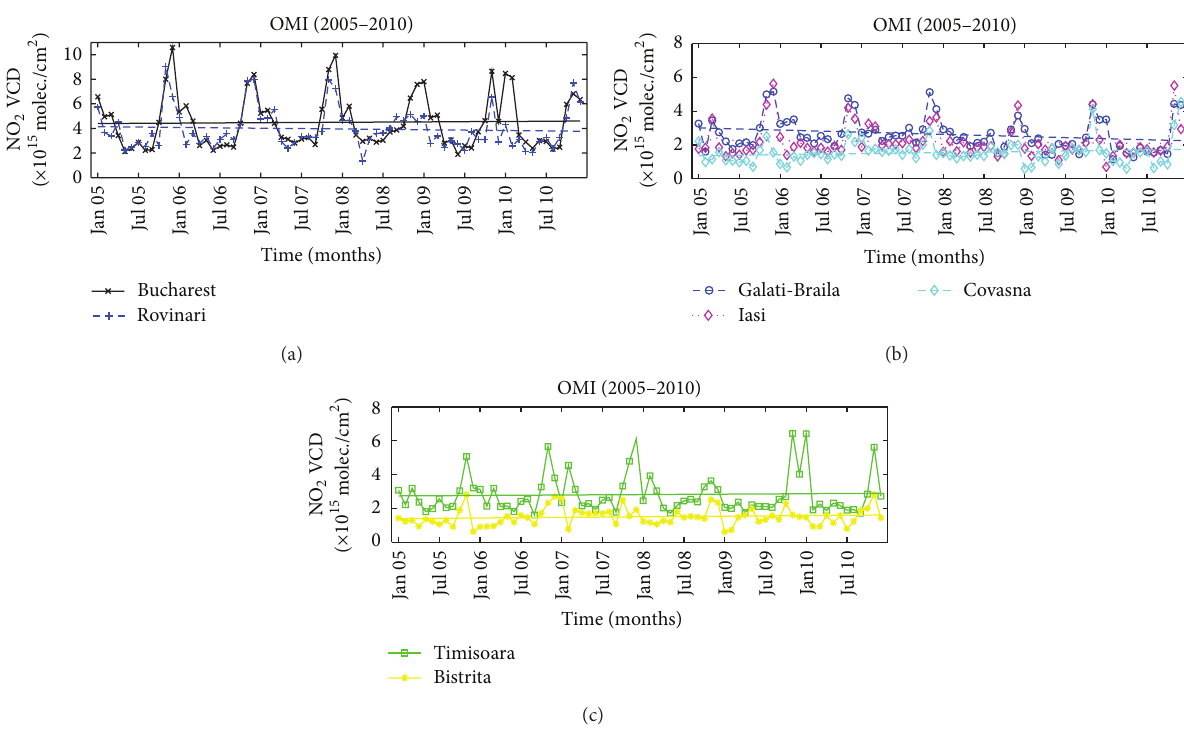
Figure 4: NO 2 time series obtained with the OMI instrument over selected cities.